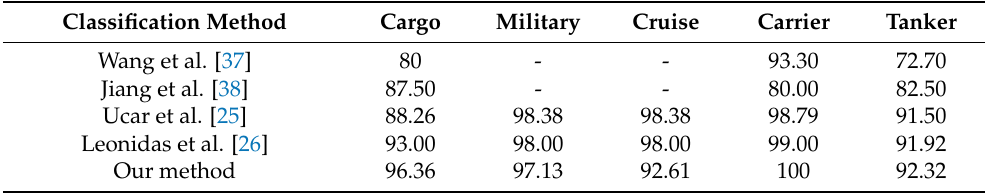
Table 9. Classification result of MARVEL with state-of-the-art